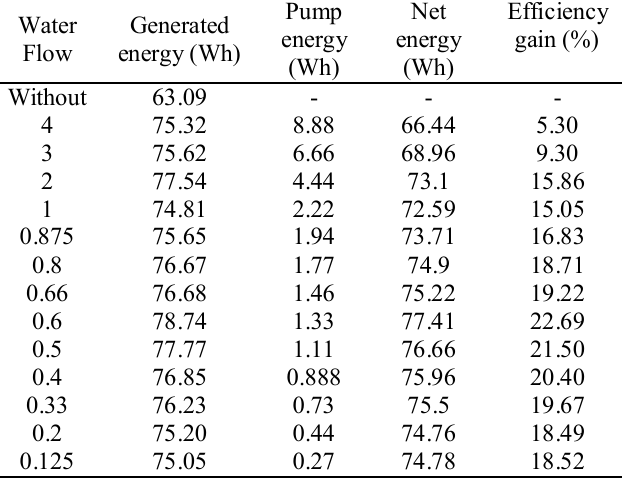
TABLE VI N ET EFFICIENCY GAIN OF THE PV PANEL WITH COOLING SYSTEM